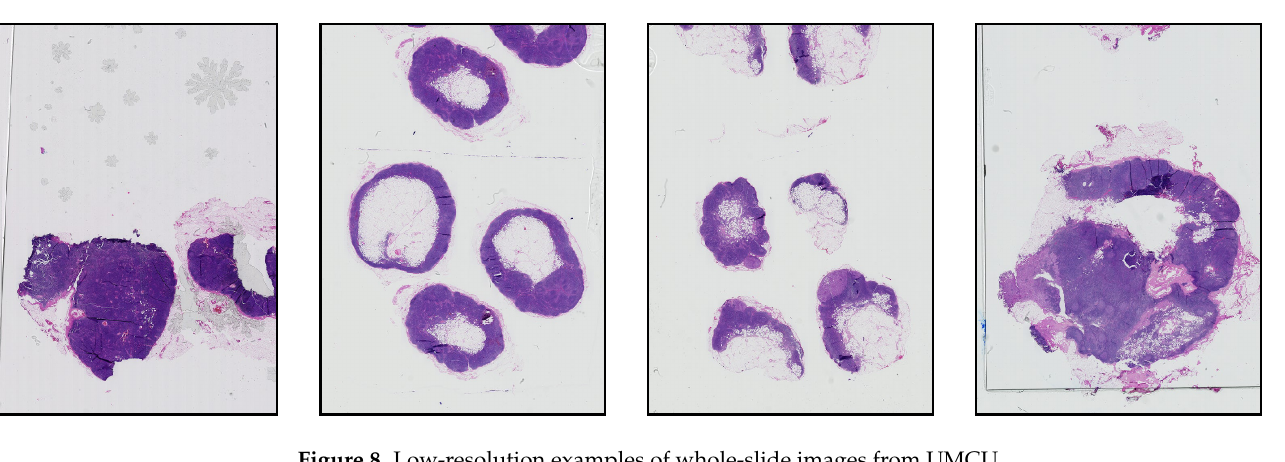
Figure 6. Low-resolution examples of whole-slide images from RUMC.